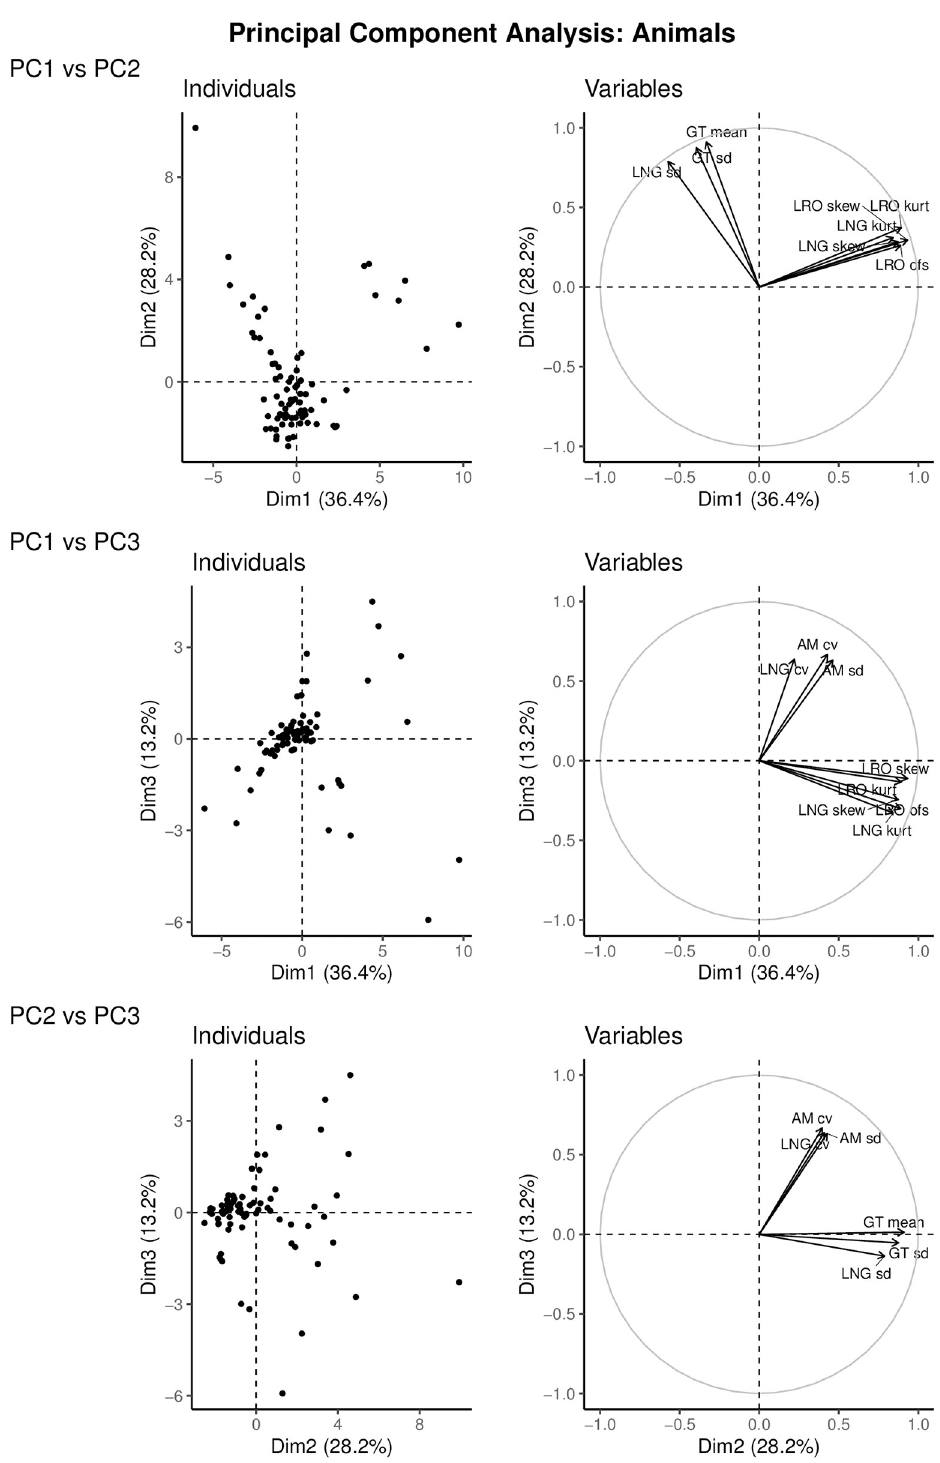
Fig 2. Principal component axes of 83 populations of animals. The right-hand graph shows the variables with the highest loadings onto these axes to facilitate visual understanding. Animal populations are primarily distributed along an axis representing measures of uncertainty in LRO and longevity (36.4%), followed by an axis representing generation time and longevity, and variation within these (28.2%). A third axis represents variation in timing of reproduction